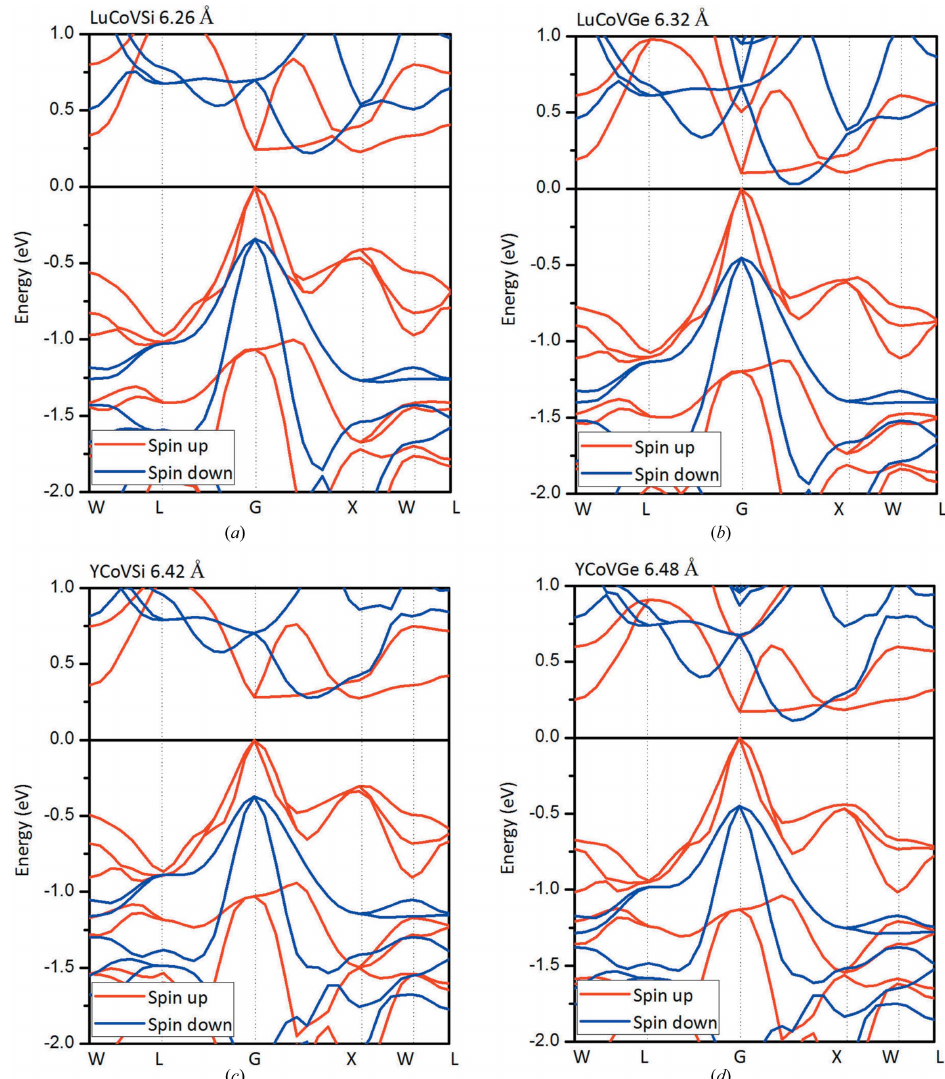
Figure 3 Calculated band structures for the rare earth-containing EQH compounds ( a ) LuCoVSi, ( b ) LuCoVGe, ( c ) YCoVSi and ( d ) YCoVGe at their equilibrium lattice constants.